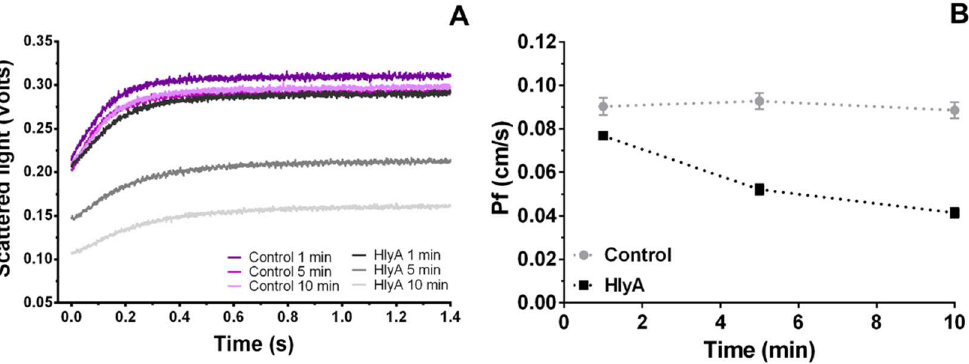
Figure 2. ( A ) SSC kinetics of HlyA pre-treated RBCs . RBCs suspensions at 10% hematocrit were treated with HlyA 100 ng/mL for 1, 5 and 10 min at 37 °C. After preincubation, cells were exposed to a hyperosmotic medium and the osmotic shrinkage of the cells was monitored by measuring the SSC signal in stopped-flow equipment as indicated in Section 4.7. Control experiments were performed in the absence of toxin. ( B ) Osmotic water permeability (P f ) as a function of time of HlyA preincubation. Values of P f were calculated as detailed in Section 4.8 from SSC data. Data is represented as a function of the time during which cells were pre-exposed to 0 (control) or 100 ng/mL HlyA before stopped-flow experiments were performed. Values represent means ± S.E.M. (Control, N = 18; HlyA, N = 15).